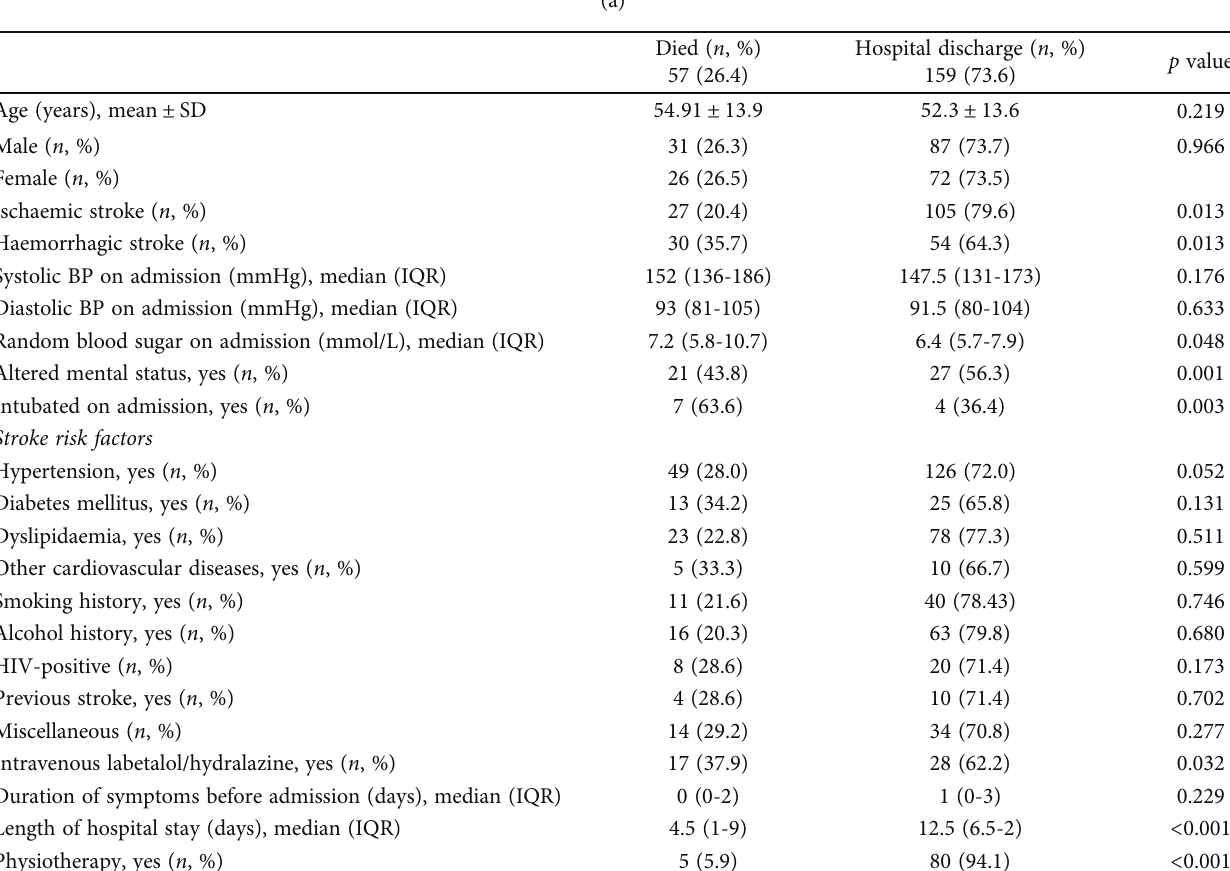
Table 2: Comparisons of in-hospital stroke outcomes between patients that died and